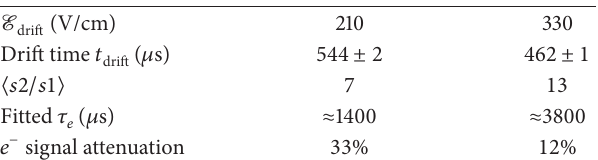
Table 3: Effective electron lifetime and signal attenuation (for particles travelling the whole volume) estimated for two-field values in WArP 100